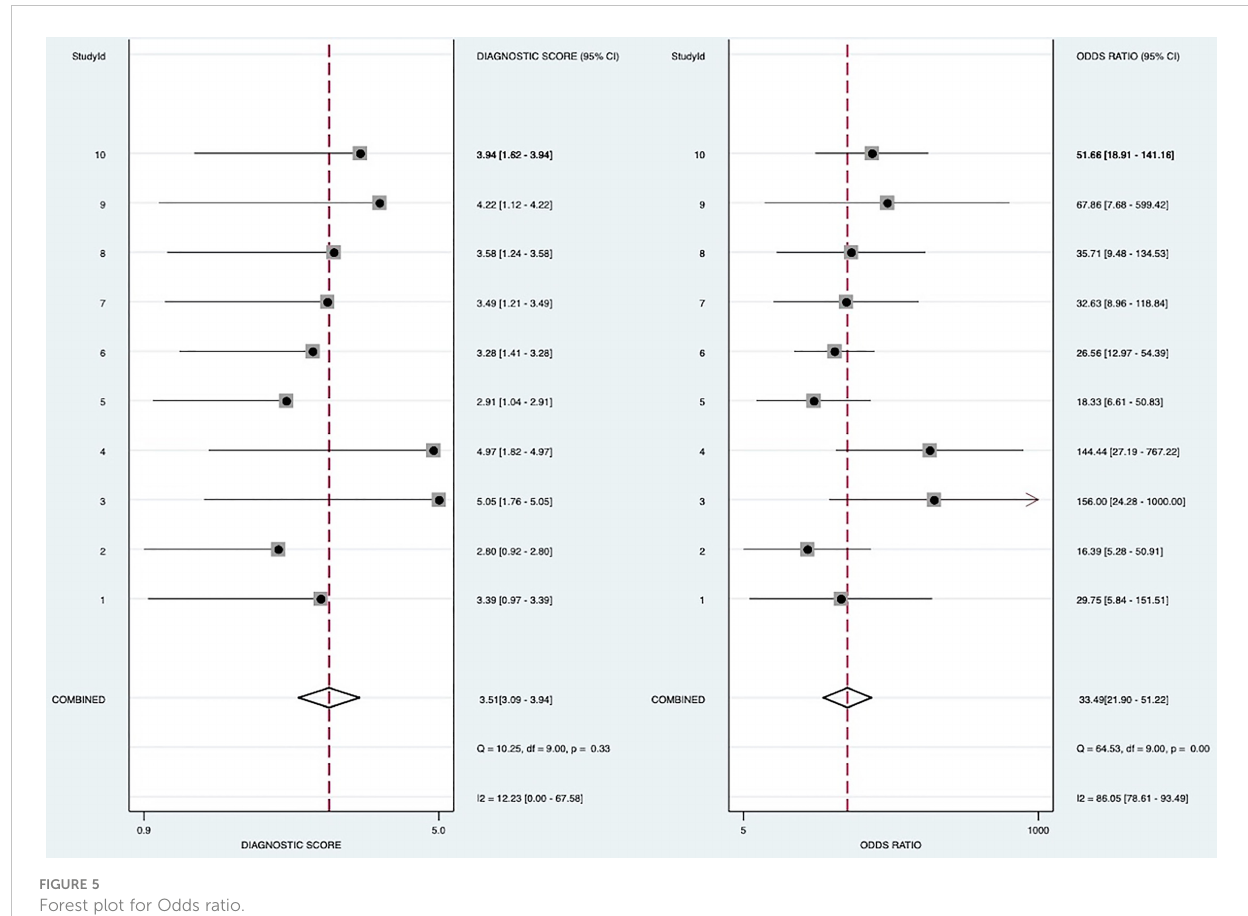
FIGURE 5 Forest plot for Odds ratio.